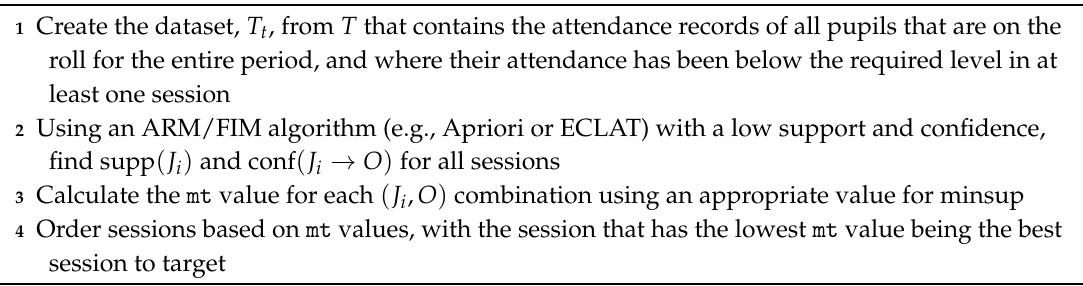
Algorithm 1: Identifying target sessions using the mt